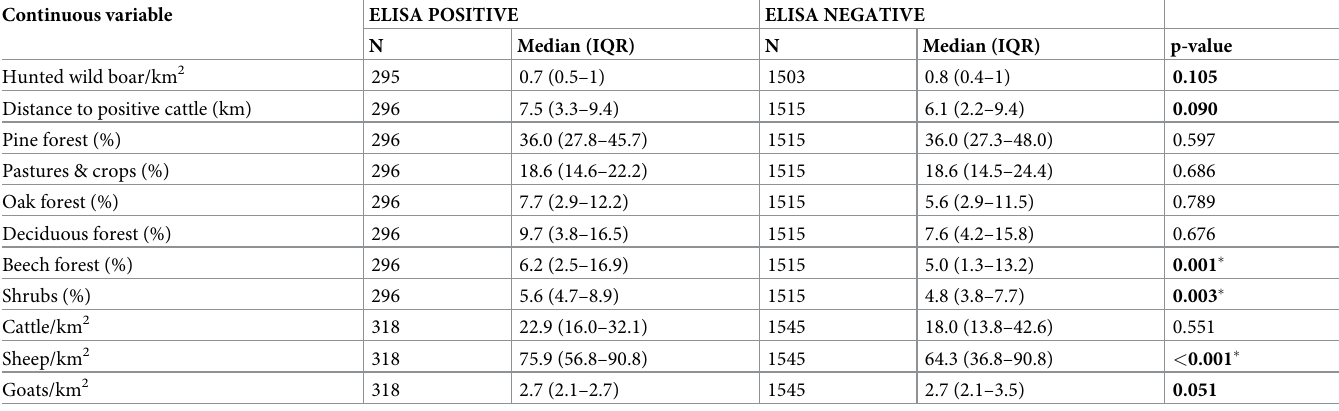
Table 2. Descriptive statistics of the continuous variables values among positive and negative wild